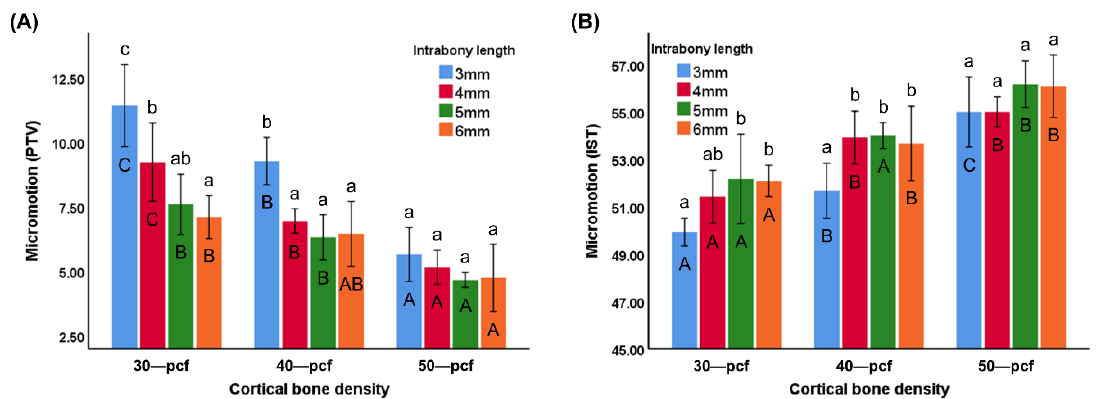
Figure 9. Micromotion represented as ( A ) periotest value (PTV) ( B ) implant stability testing value (IST). Different uppercase letters indicate a significant difference between the miniscrews inserted into cortical bone of various densities ( p < 0.05), while different lowercase letters indicate a significant difference between the miniscrews at the various intrabony lengths ( p < 0.05).